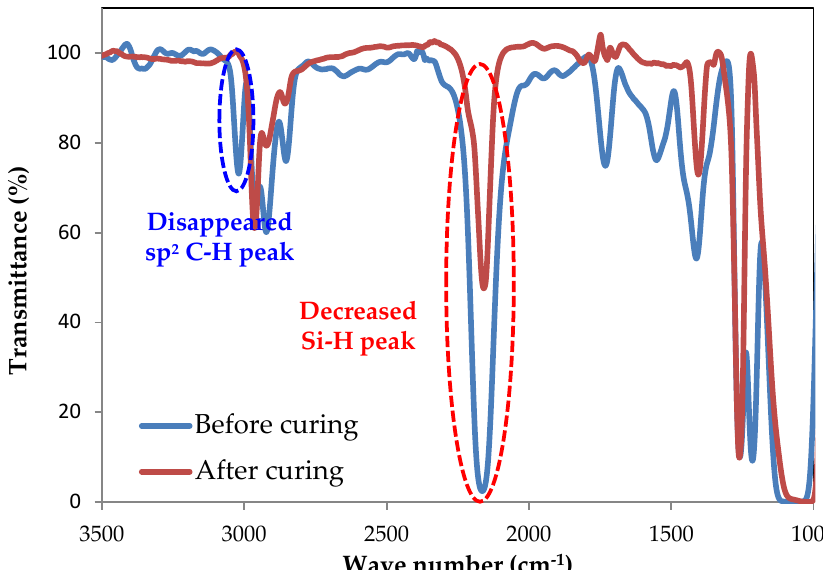
Figure 5. FT-IR spectra before and after the film formation by hydrosilylation. The sp 2 C–H stretching peak at 3100 cm − 1 from the acrylate and Si–H stretching peak at 2150 cm − 1 from H-PDMS disappeared after the curing was finished by hydrosilylation.